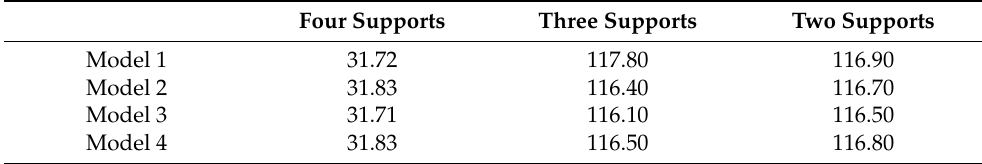
Table 3. The maximum vertical displacements for di ff erent FE models (units in mm). Four Supports Three Supports Two Supports